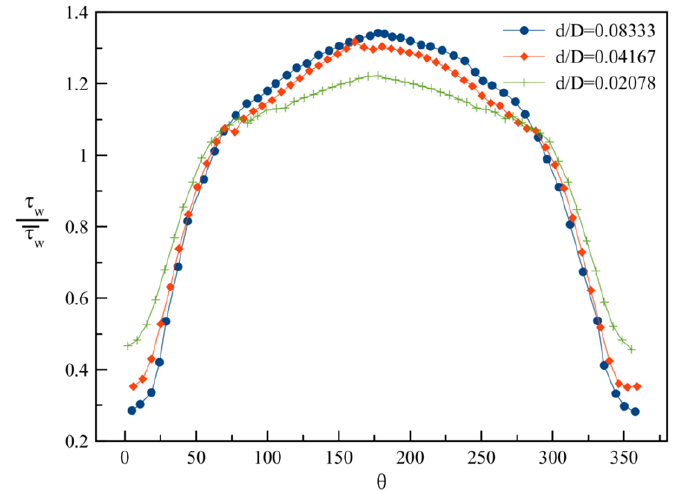
Figure 2. Local wall shear stress distribution along the circumference, Re = 25,000. If d/D is large, the effect of centrifugal force increases, causing the wall shear stress to be higher than in the case of a straight tube throughout most of the tube wall surface.